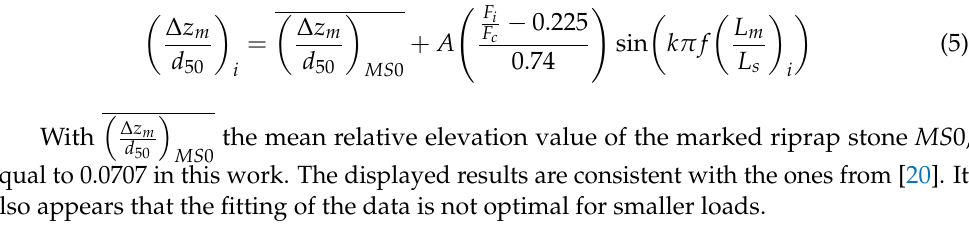
(cid:16) ∆ (cid:17) z m With the mean relative elevation value of the marked riprap stone MS 0, d 50 MS 0 equal to 0.0707 in this work. The displayed results are consistent with the ones from [20]. It also appears that the fitting of the data is not optimal for smaller Table 2. Critical discharge, critical load and stone-related Froude number values for each experi- mental test.